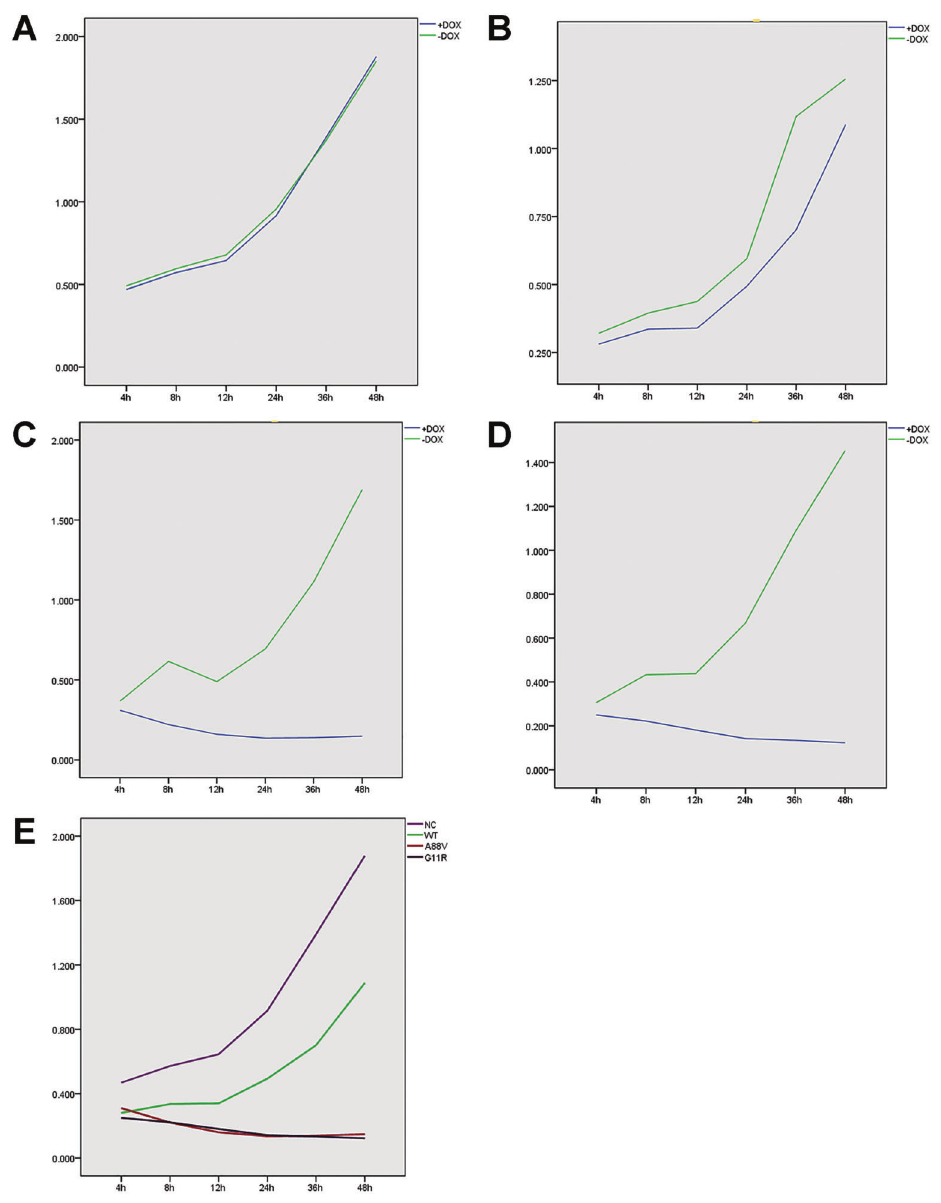
Figure 2. CCK8 test of cell proliferation showing absorbance values of four cell lines induced or not by doxycycline ( + DOX, and – DOX): A , Negative control (NC); B , wild type (WT), C , A88V mutant, D , G11R mutant, and E , HaCat cells. Statistical analysis was done with the t